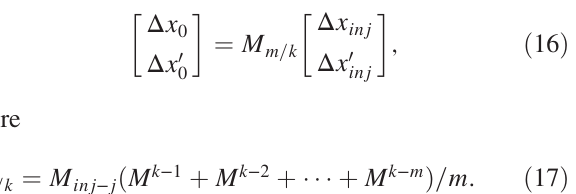
FIG. 5. Similar to Fig. 4 but with the total tracking turns increased to 20. The m and k in Eq. (17) were both 3, and the number of circulation turns after injection [ n in Eq. (6)] was 18. R4BPM12 was marked as the observation point during